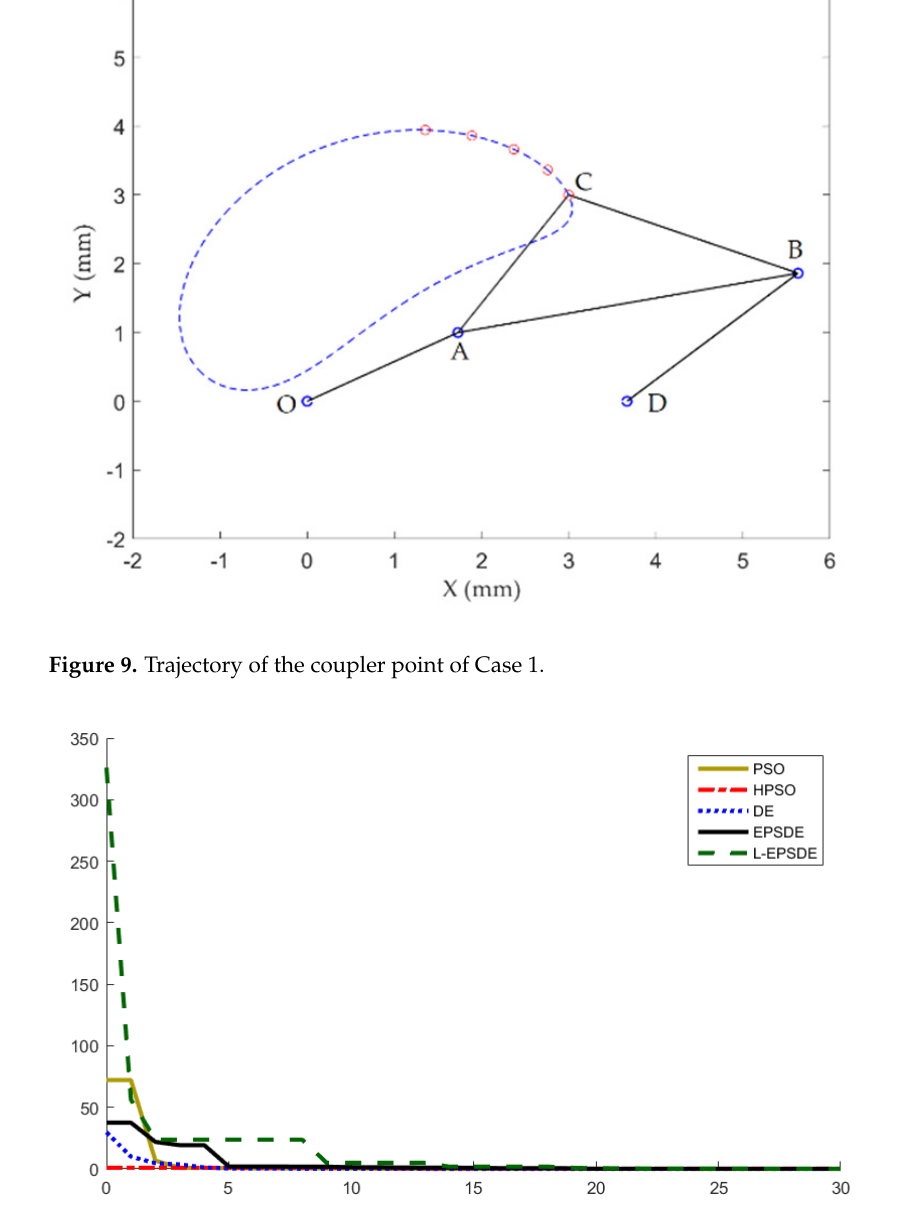
Figure 10. Convergence rate of the five metaheuristic methods for Case 1. Case 2: Irregular closed curve (18 target points, 10 design variables).